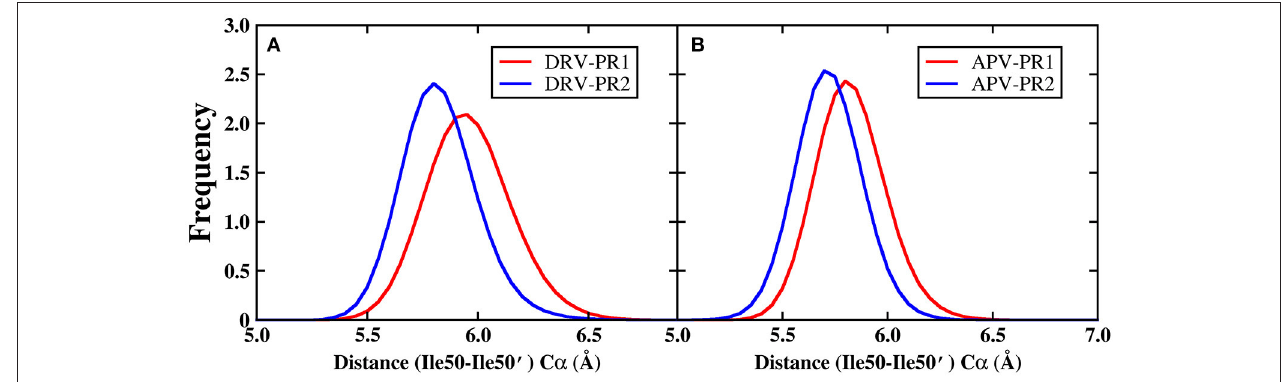
FIGURE 13 | Decomposition of the binding free energy on a per-residue basis. (A) DRV-PR1 complexes. (B) DRV-PR2 complexes. (C) APV-PR1 complexes. (D) APV-PR2 complexes.